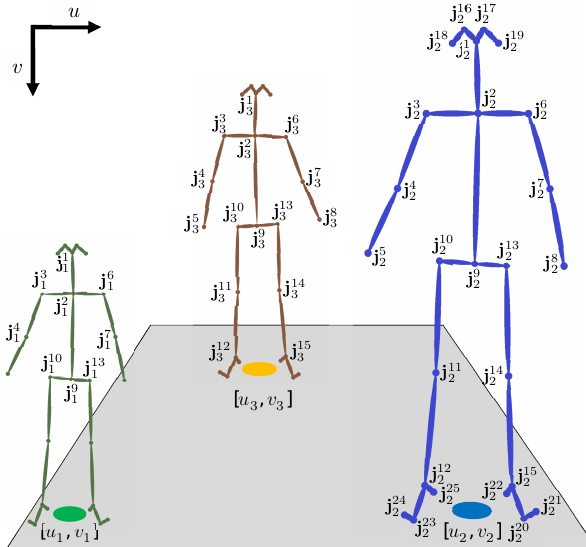
Figure 2. An example pose estimation for three subjects with varying heights and spatial positions. The OpenPose 25 estimated joints are indexed on the right (blue) skeleton. The remaining two subjects have some undetected joints, but their joint indexing remains the same. The ground position of each subject is estimated by the midpoint of their feet joints. The user-defined region of interest is depicted in gray and includes all three ground